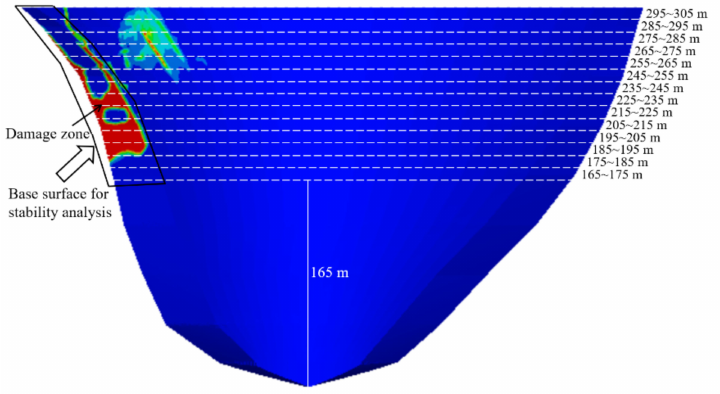
Figure 15. Locations used in antisliding stability